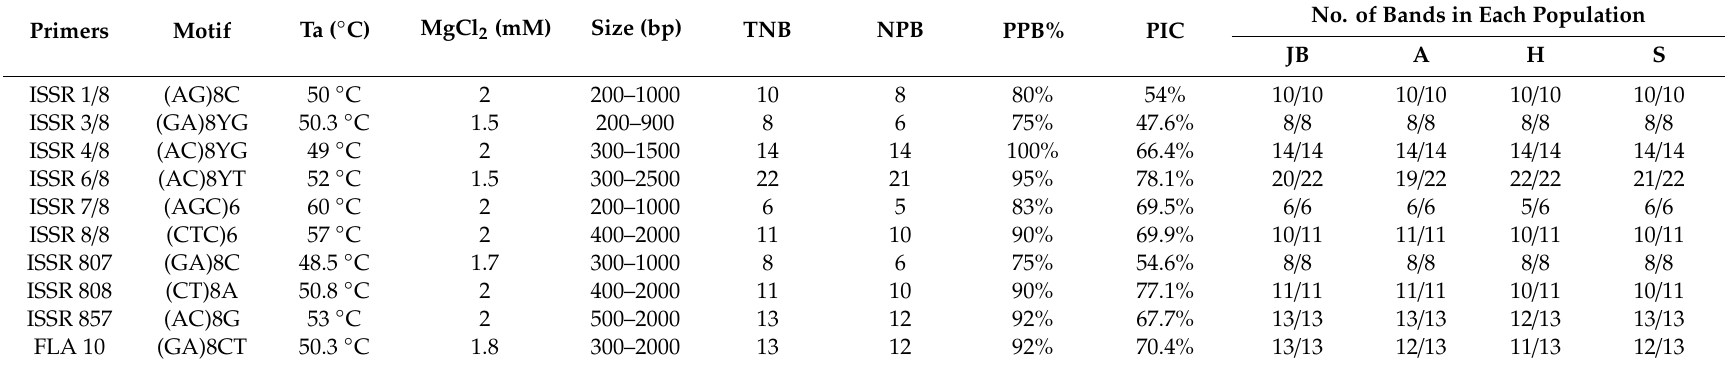
Table 2. List of 10 inter-simple sequence repeat (ISSR) primers, annealing temperatures (Ta), MgCl 2 concentration optimized for PCR amplification, and length of the amplification